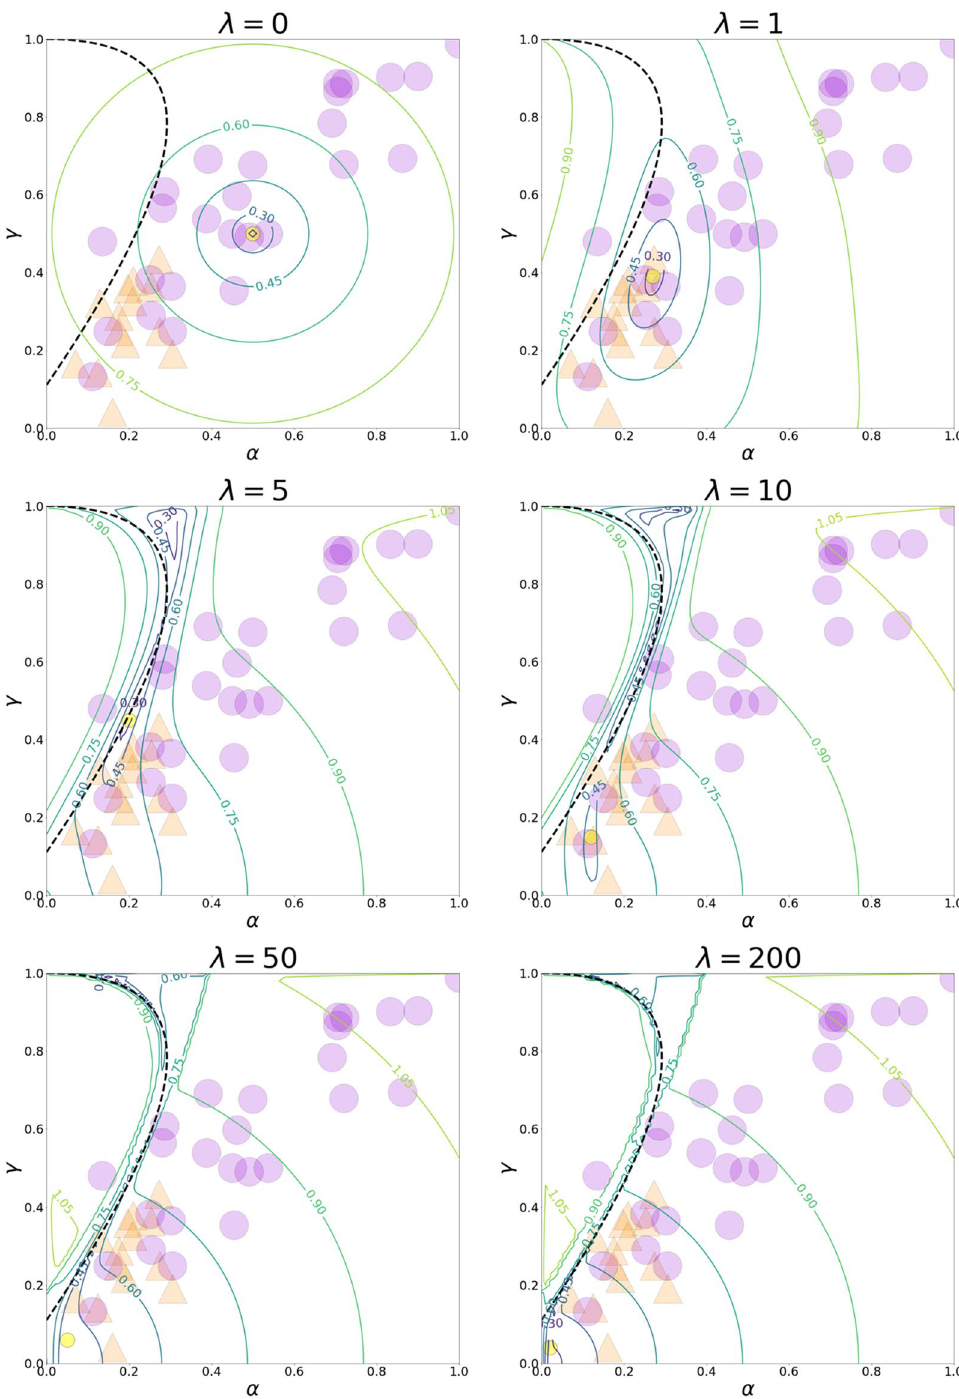
Figure 4. The panels plot contour lines of objective function (19) (the objective function is shown to the power of 1/5 for demonstrative purposes) for different values of rationality. The dashed line represents the Nash equilibrium. The yellow circles symbolize solutions to the corresponding optimization problems (QRE for PD in Markov strategies). The orange triangles indicate participants’ strategies before socialization, while violet circles represent participants’ strategies after